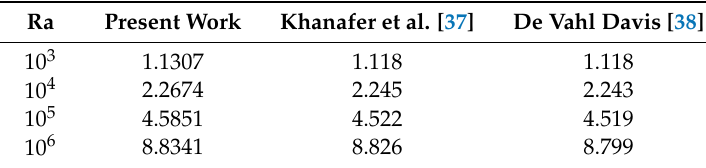
Table 4. Comparison between present results and other works for Nu avg